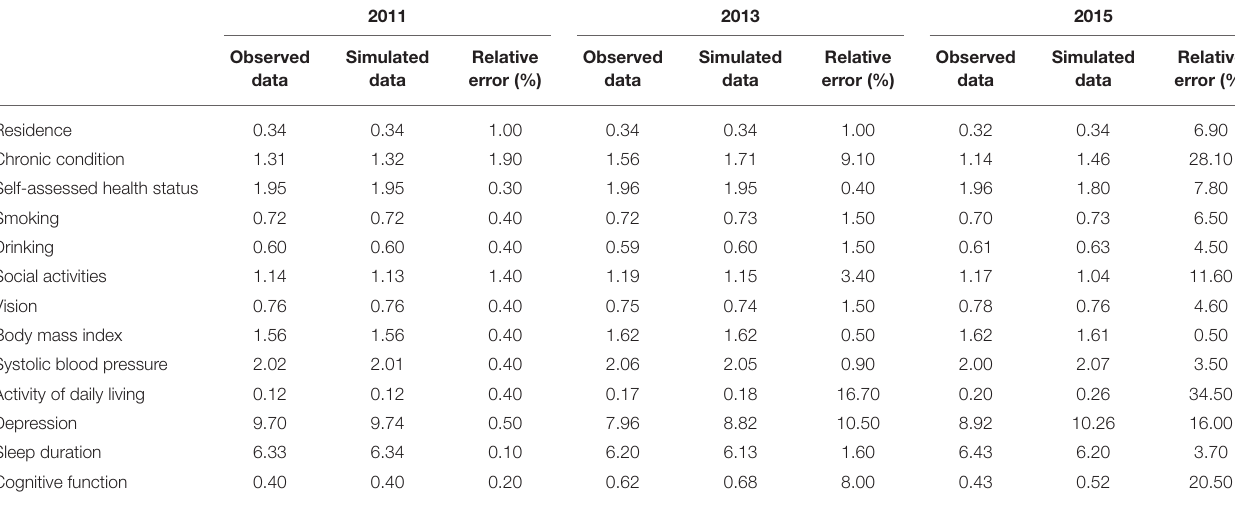
TABLE 2 | The comparison of actual observation and simulated average values.